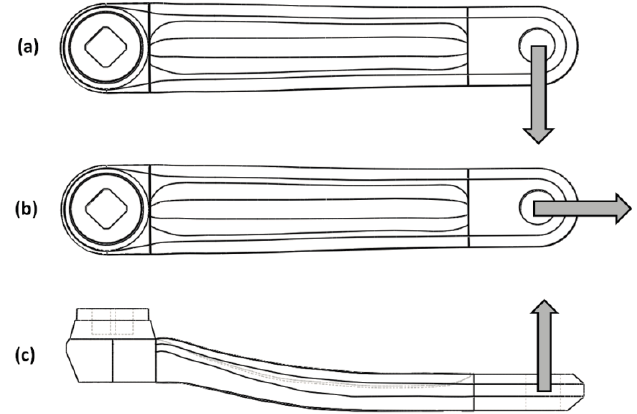
Figure 4. Direction of the applied force component in the crankset: ( a ) perpendicular force; ( b ) parallel force; ( c ) lateral